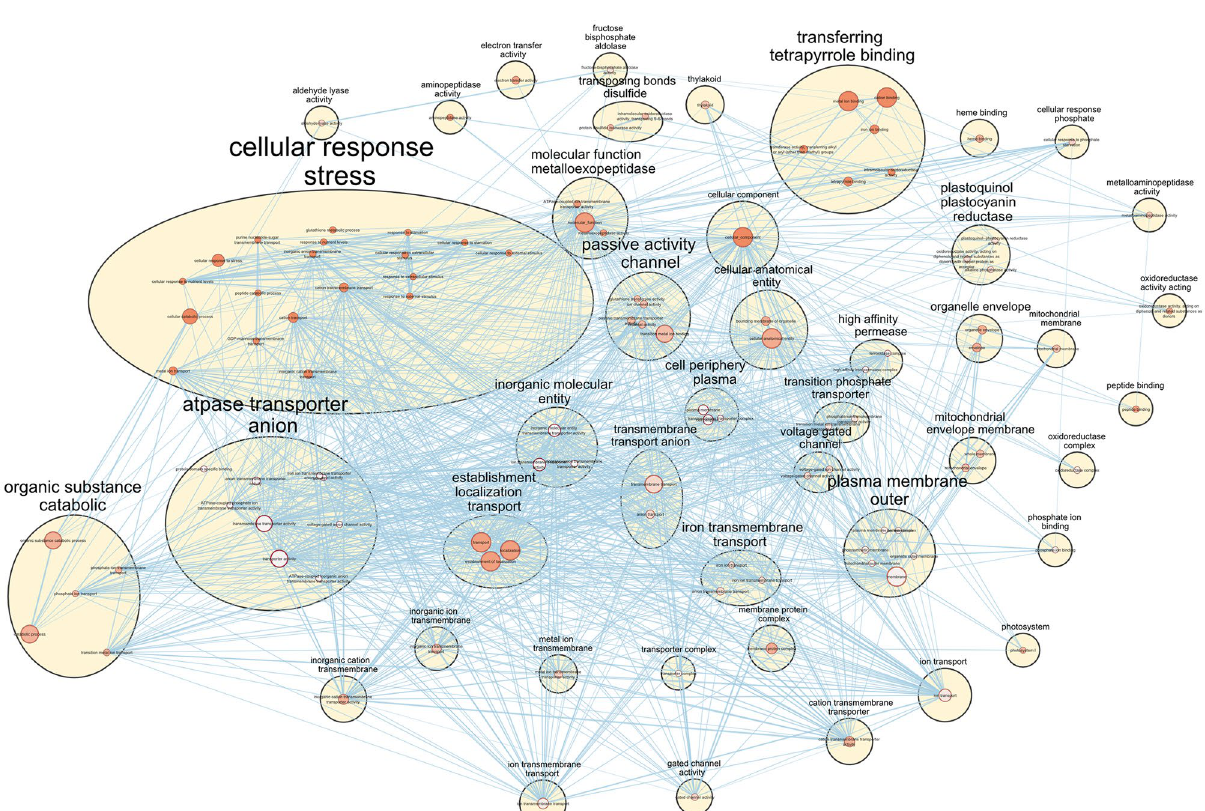
Figure 8. Negatively affected biological functions or gene ontology terms in T.pseudonana after 48 h of exposure to WAF relative to Control. The size of the node corresponds to the size of the gene sets and the color of the node ranging from orange-white-blue indicates increasing FDR q